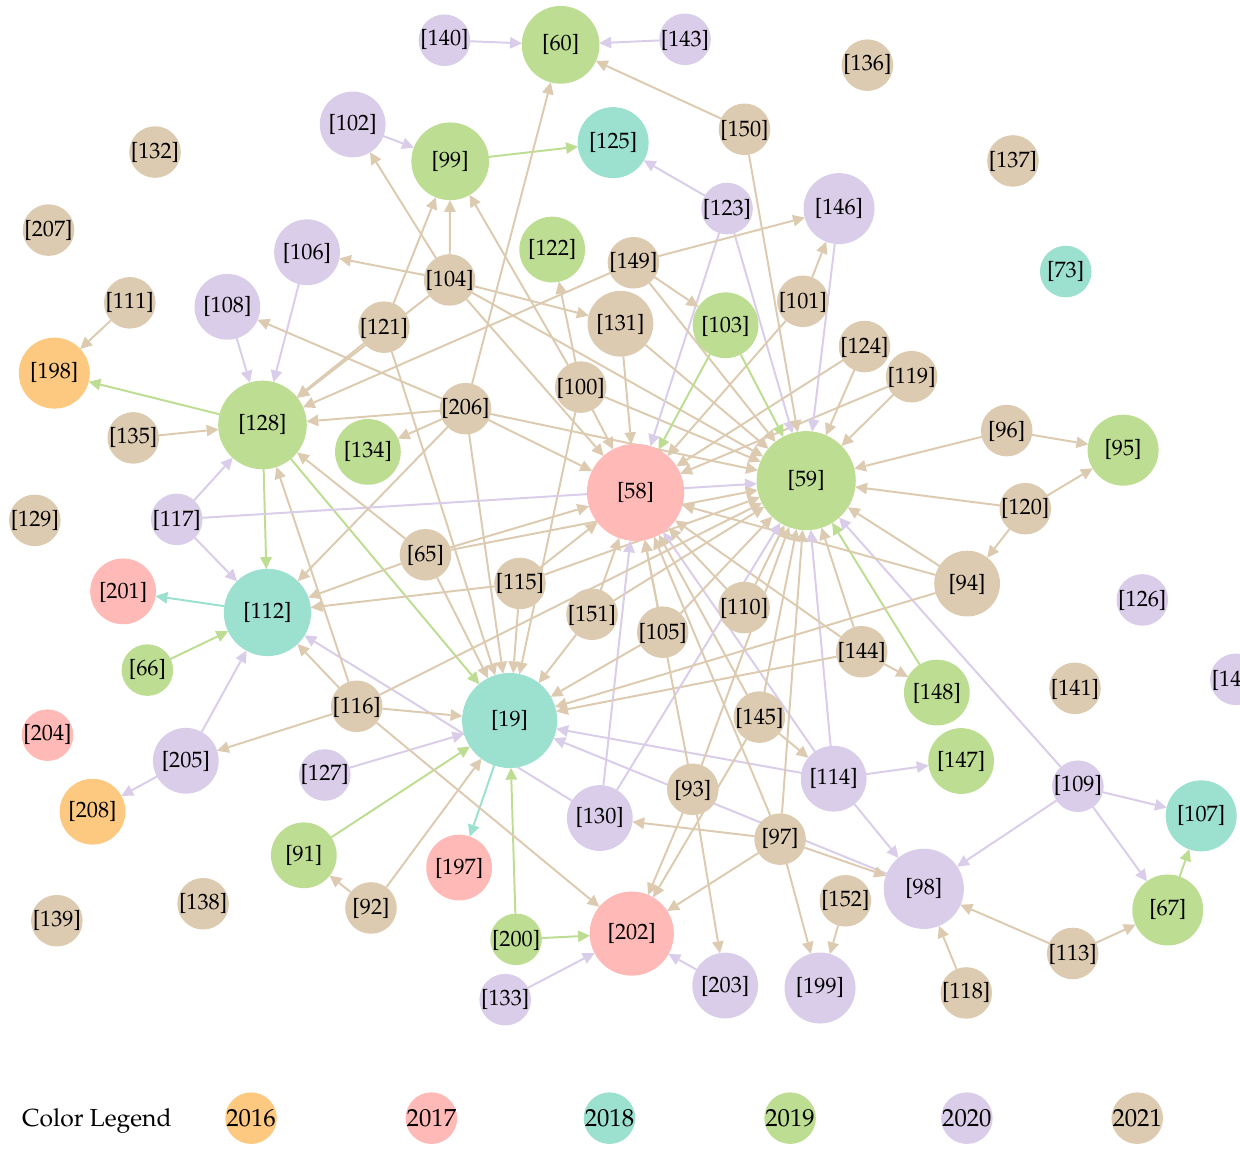
Figure 7. Co-reference